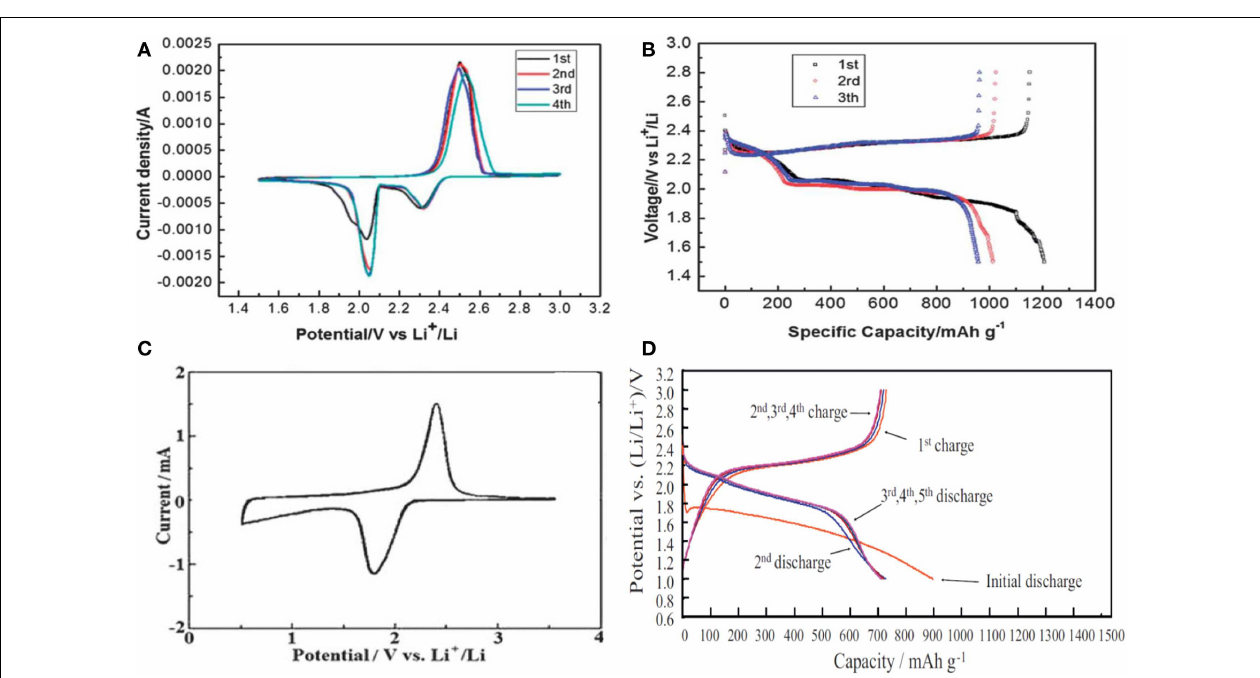
FIGURE 1 |Typical electrochemical characteristics of Li/S cells . (A,B) S-C composite, and (C,D) SC compound. Reproduced with permission ofWang et al. (2012b), Duan et al. (2013), Miao et al. (2013).